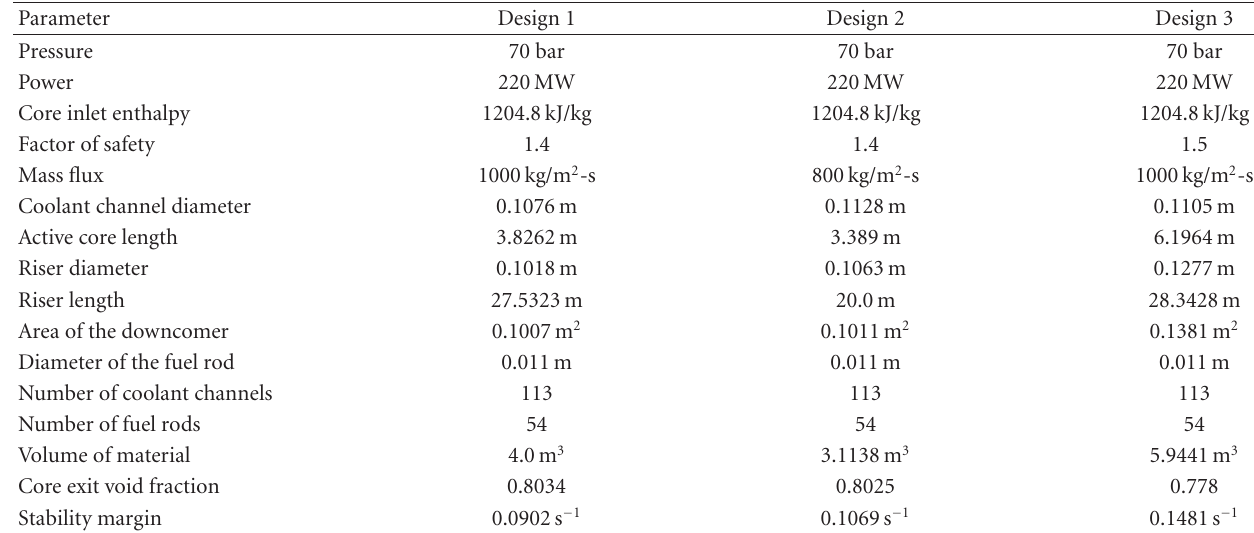
Table 3: Design parameters at minimum material